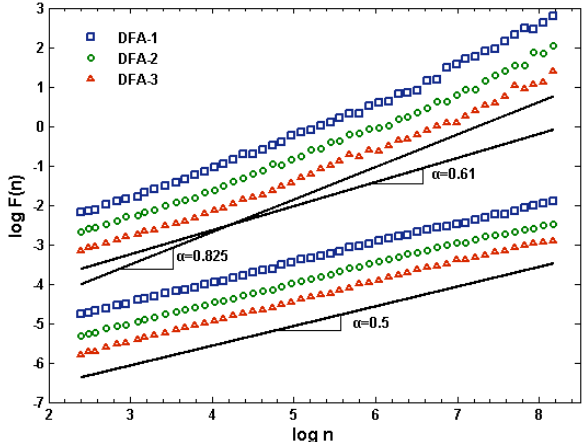
Fig. 4. The DFA- l for the original inter-event time series (top) and Figure 4: The DFA- l ( l =1,2,3) for the inter-event time series ( F ( n ) shifted vertically 2 the surrogate series (bottom). F(n) has been shifted vertically for for clarity). Bottom the DFA- l ( l =1,2,3) for the surrogate inter-event time series. 3 clarity. The different symbols correspond to different orders l (l = 1 , 2 , 3) of